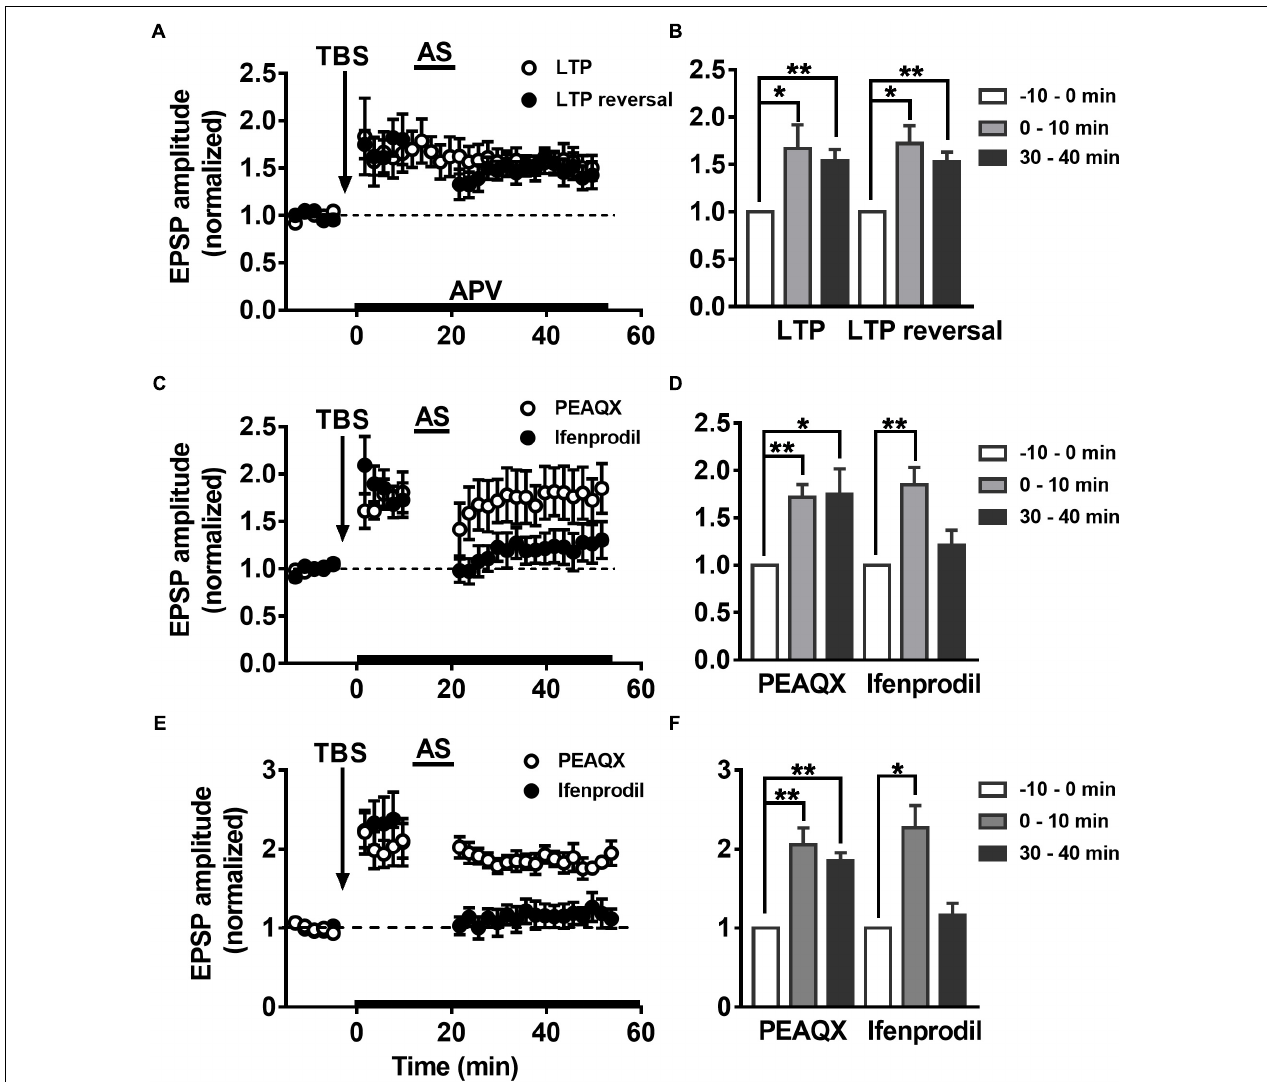
FIGURE 5 | Differential modulation of LTP reversal in the DGCs by NMDAR subtypes. (A) LTP (open circles) and LTP reversal (solid circles) recorded from adult mature DGCs in the presence of NMDAR blocker APV. APV was administered at 10 min post-LTP induction, indicated by the black horizontal bar. (B) Summary of the means at different time points during recordings of LTP and LTP reversal after perfusing APV in (A) . APV had no obvious effect in LTP maintaining, but it blocked the reversal of LTP induced by TBS. Values represent the mean ± SEM ( ∗ p < 0.05, ∗∗ p < 0.01; paired t -test). (C) LTP reversal recorded from adult mature DGCs in the presence of NR2AR antagonist PEAQX (0.4 µ M, open circles) or NR2BR antagonist ifenprodil (3 µ M, solid circles). The antagonists were delivered after the induction of LTP in adult mature DGCs, indicated by the black horizontal bar. (D) Summary of the means at the different time points during recording of the LTP and the LTP reversal after perfusing with PEAQX or ifenprodil in (C) . LTP reversal obviously inhibited by PEAQX but not ifenprodil. Values represent the mean ± SEM ( ∗ p < 0.05, ∗∗ p < 0.01; paired t -test). (E) LTP reversal recorded from adult-born 6-week-old DGCs in the presence of PEAQX (open circles) or ifenprodil